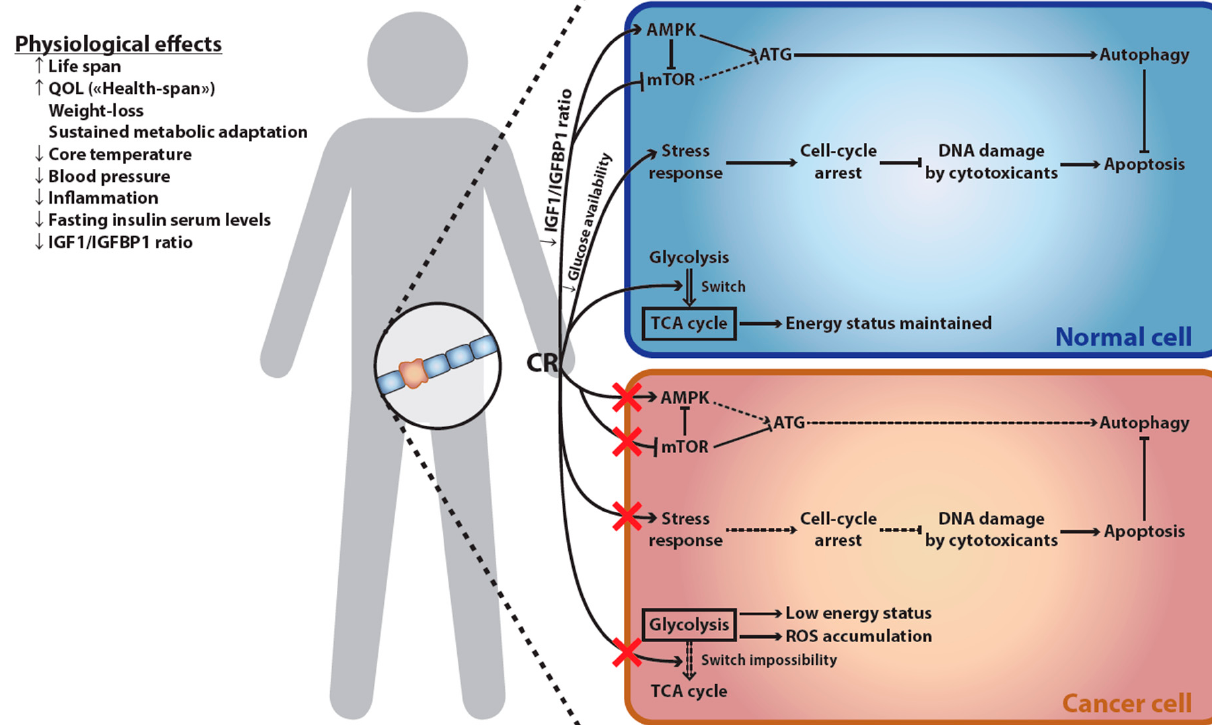
Figure 1. Cellular and physiological effects of ER. Consequences of ER at the physiological level ( left ) and its differential impact on normal versus cancer cells ( right ). ER has broad-ranging physiological effects, increasing both lifespan and QOL. This increase in the length and quality of life is strongly associated with ER-induced weight loss and sustained